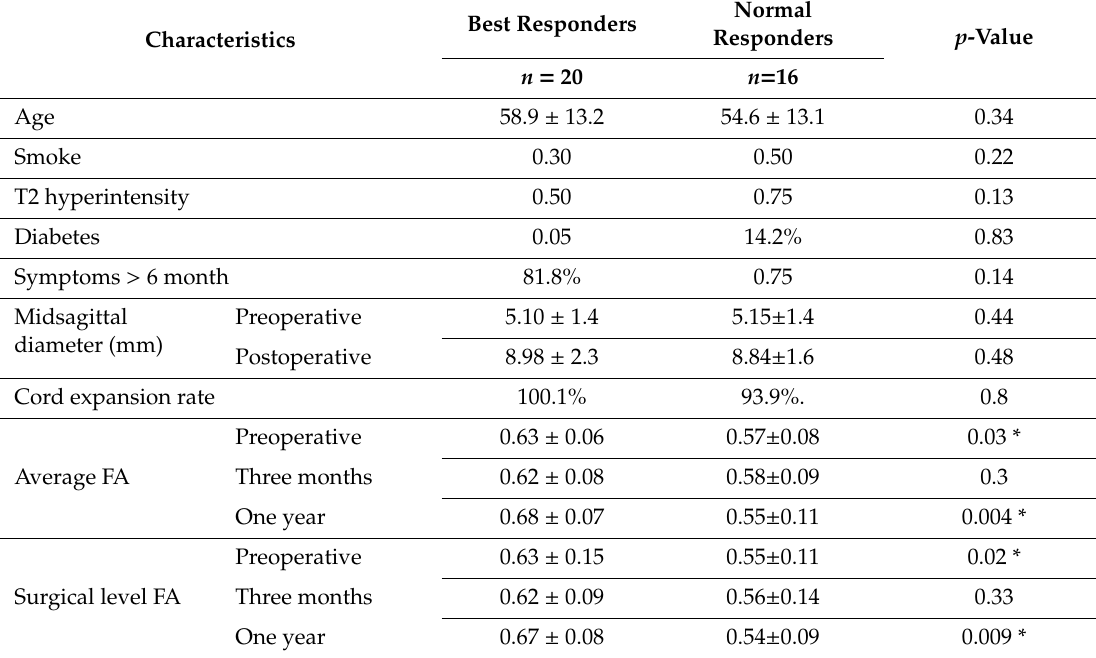
Table 2. Di ff erences in characteristics between best responders and normal